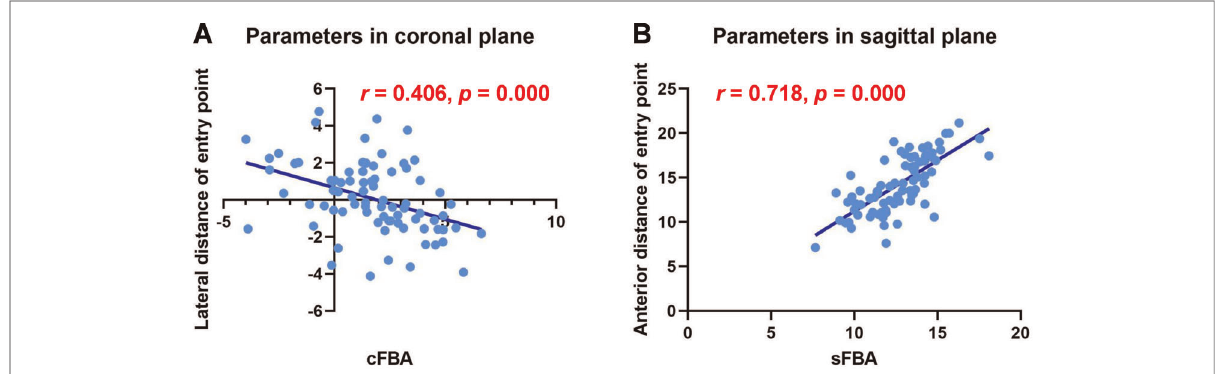
FIGURE 5 Linear regression of parameters in coronal and sagittal planes. ( A ) The sFBA showed a strong correlation with the anterior distance of the proper entry point in the sagittal plane ( r =0.718, p =0.000). ( B ) The cFBA showed a moderate correlation with the lateral distance of the proper entry point in the coronal plane ( r =0.406, p =0.000).